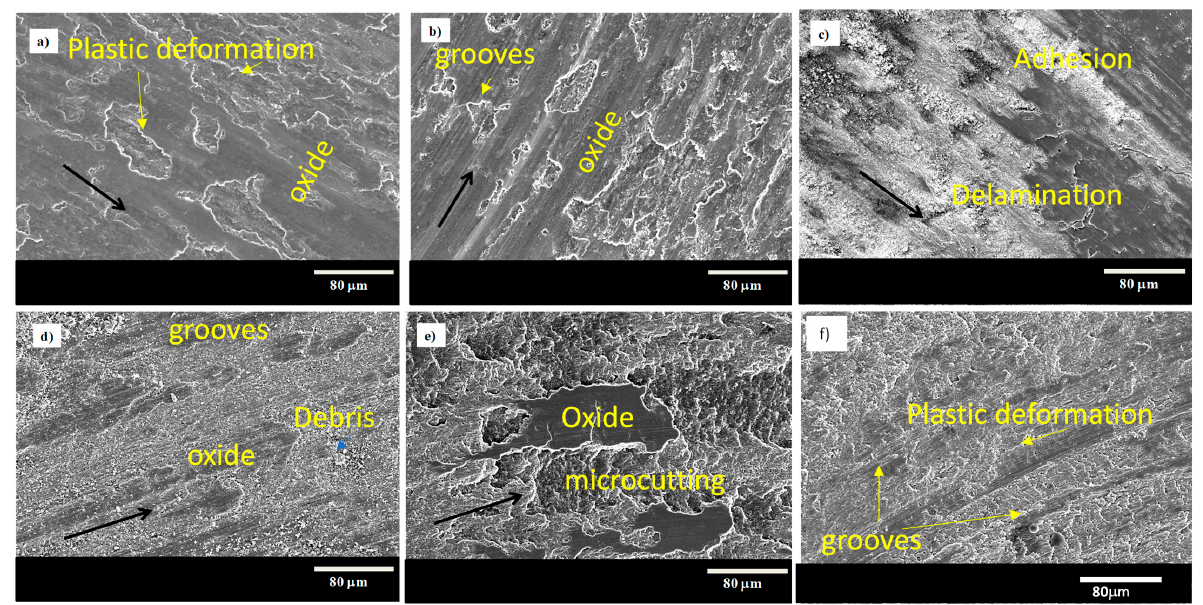
Figure 9. Morphologies of the worn surface at a load of 10 N, ( a , b ) aluminum surfaces, ( c , d ) MMC, and ( e , f ) MMC-T6 slid with steel and alumina balls as counterfaces, respectively.